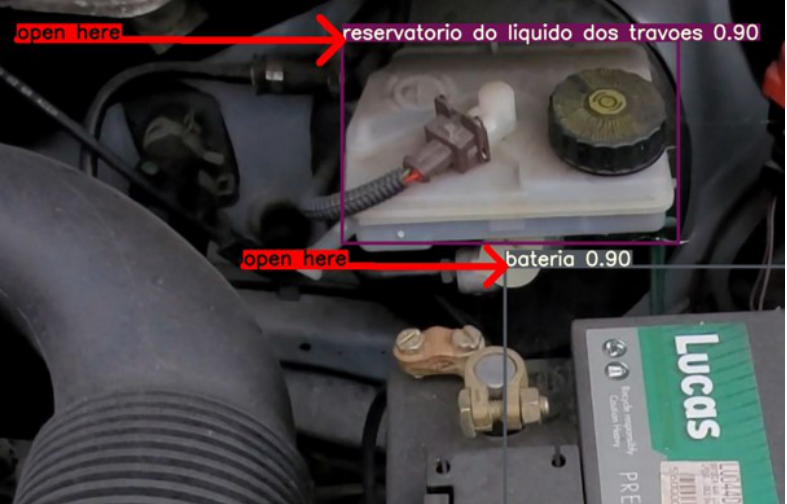
Figure 4. Example of object detection on a test image, where brakes fluid reservoir and battery are